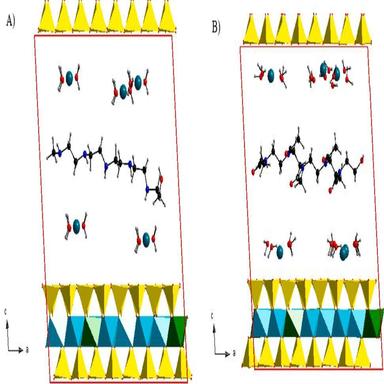
Initial structures of A) PEI-Mt, B) PMeOx-Mt. The Si(IV) tetrahedra are in yellow, the Al(III) octahedra in cyan, the Mg(II) octahedra in green. The colors of the atoms are as follows: carbon - black, nitrogen - blue, hydrogen - grey, oxygen – red, and sodium – dark cyan.